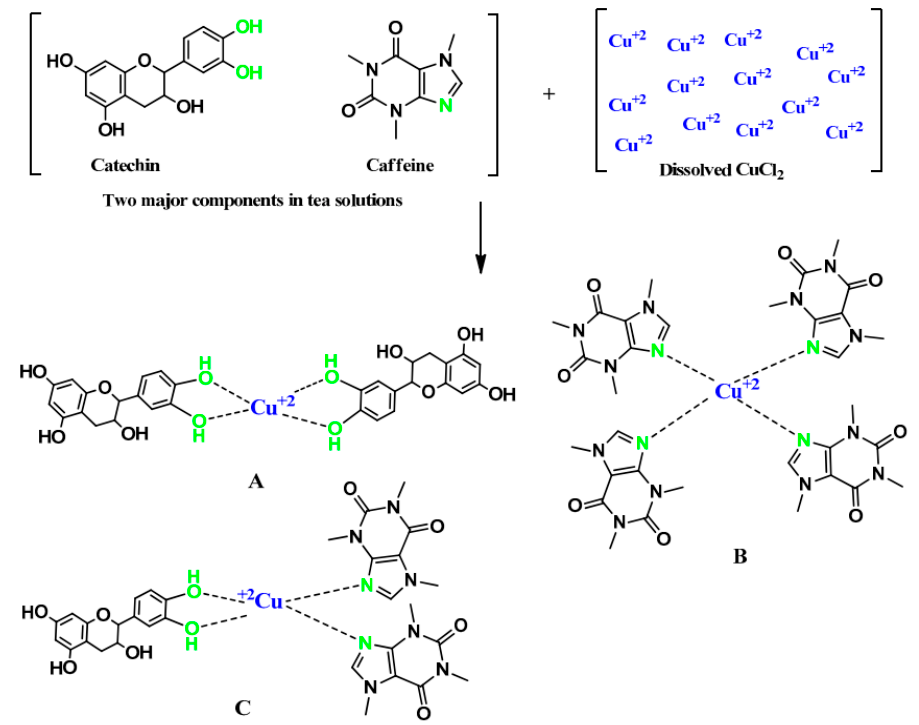
Figure 13. The proposed structure for the fabrication copper (II)-complex [118].